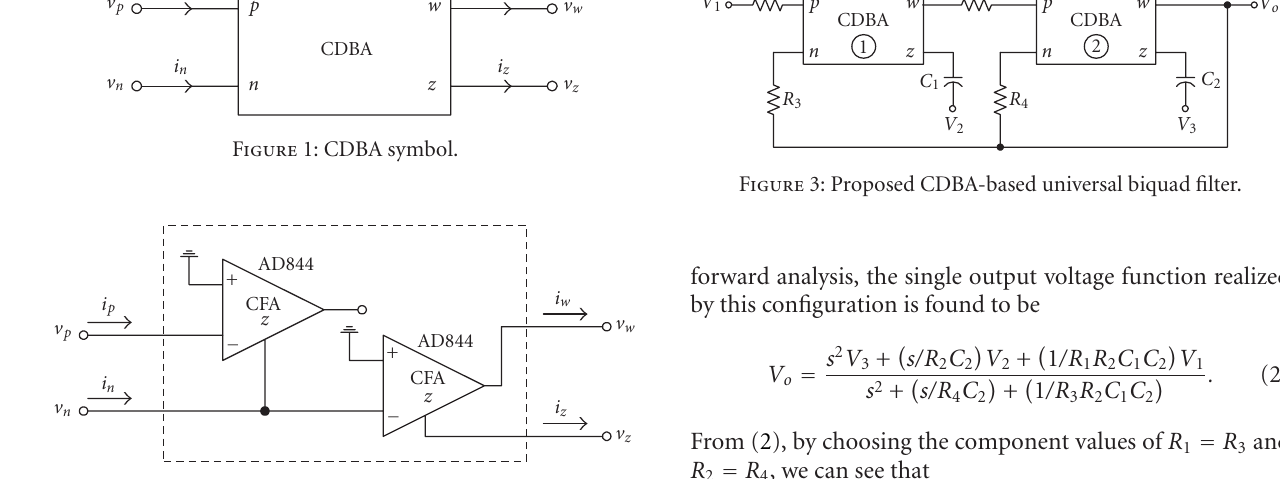
Figure 2: Implementation of CDBA using two CFAs (AD844s).